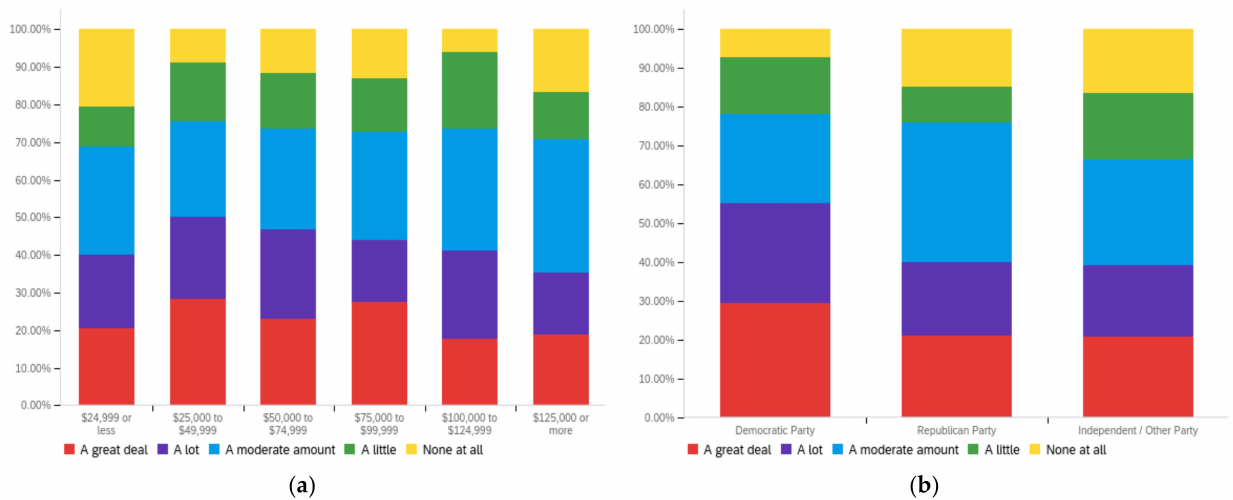
Figure A12. Article author—ideal perception impact by: ( a ) income level (top left), ( b ) political affiliation (top right) and ( c ) online usage (bottom).